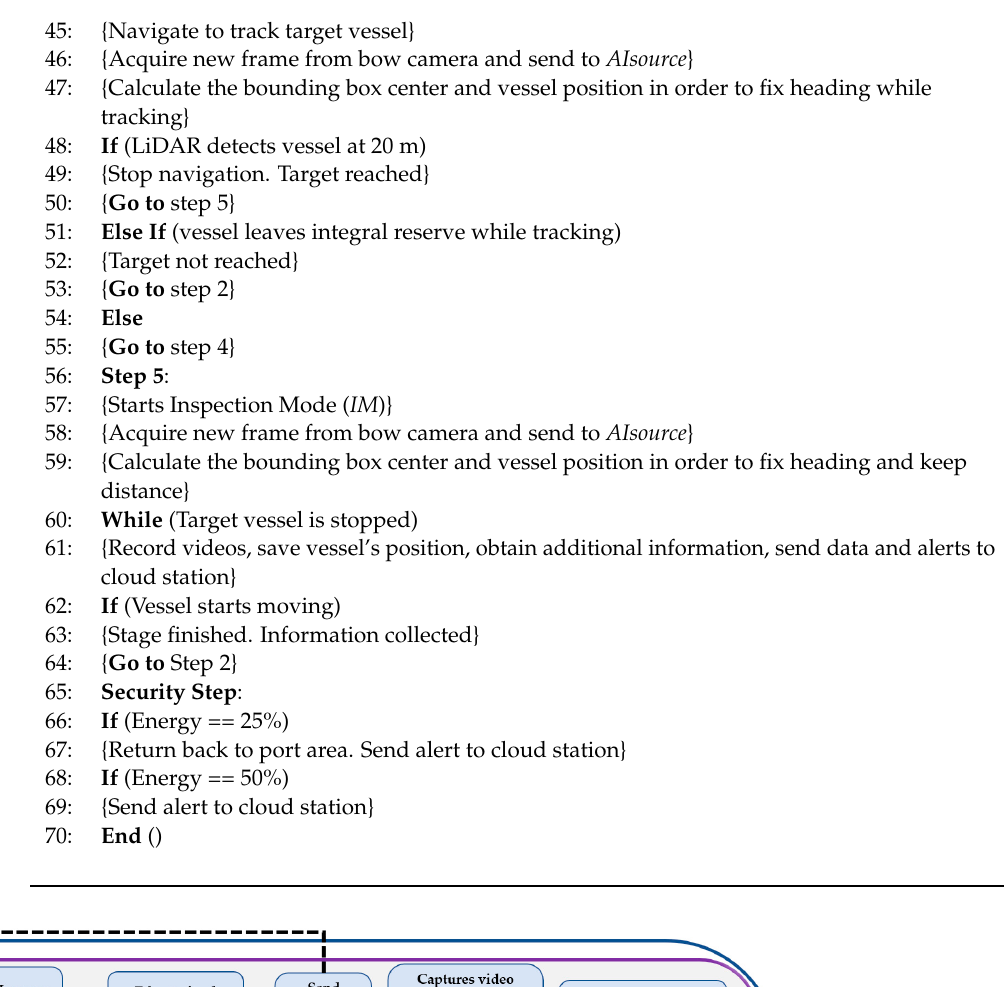
Algorithm 1. Vessel Recognition and Tracking Algorithm.